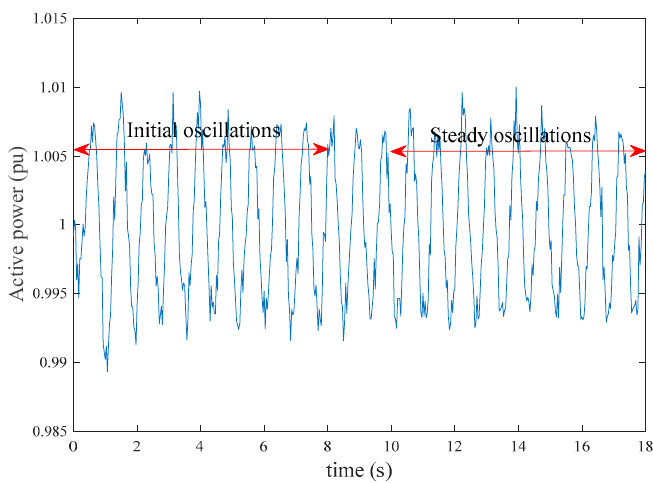
Figure 6. Natural oscillations with damping ratio close to zero.